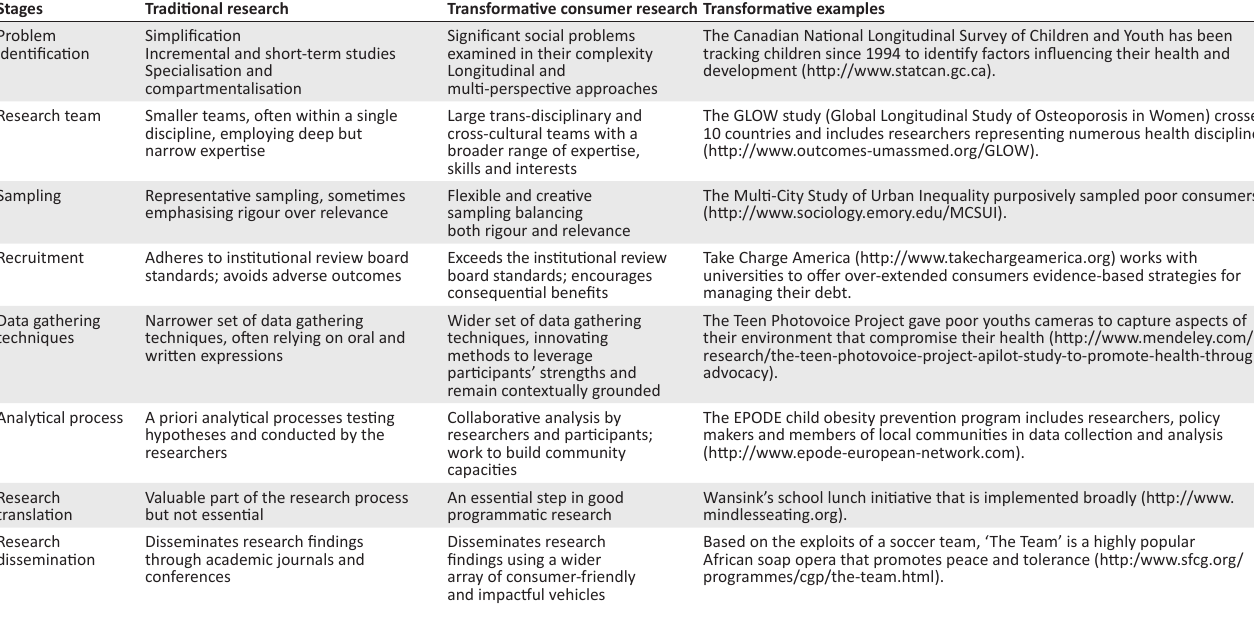
TABLE 1: Comparison of traditional and transformative consumer